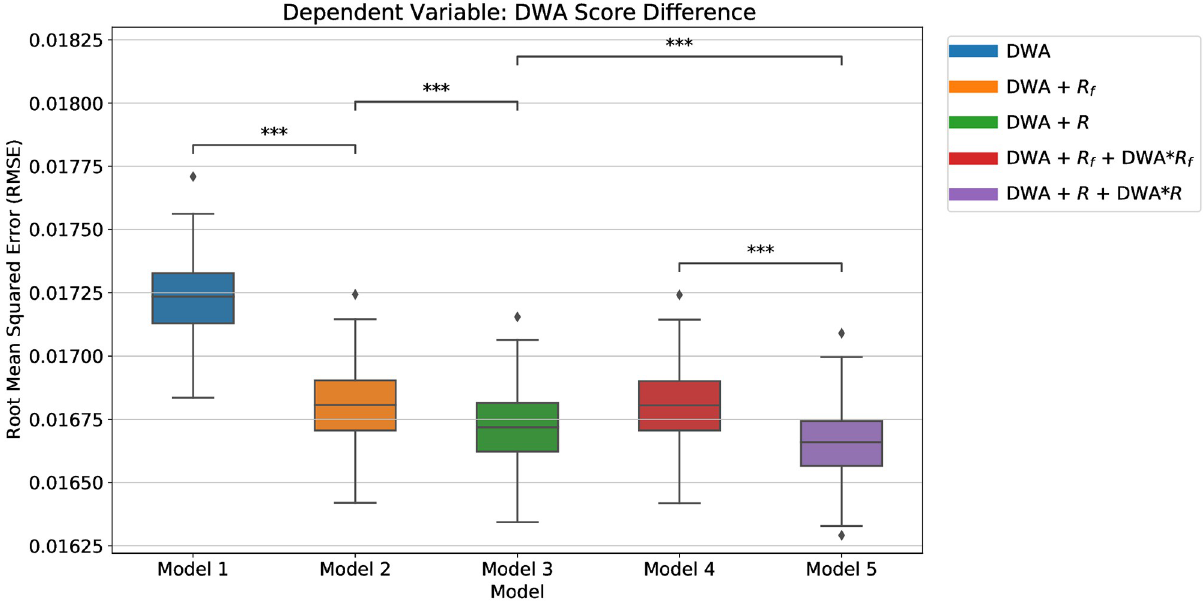
Fig 4. Workplace activities detected from syllabi predicting teaching dynamics within a field of study. We perform 5-fold cross validation and repeat 40 times (i.e., 200 trials in total) for each model and measure RMSE by the resulting model applied to the test set. Asterisks indicate the statistically significant difference between two models’ performances with Bonferroni correction. Predicting the importance of DWAs changing in nine years (2008 vs. 2017). As a baseline, model 1 only considers the current DWA score and FOS fixed effects. The other models consider the relationships between DWAs, how they interact with each other to predict how they may change in